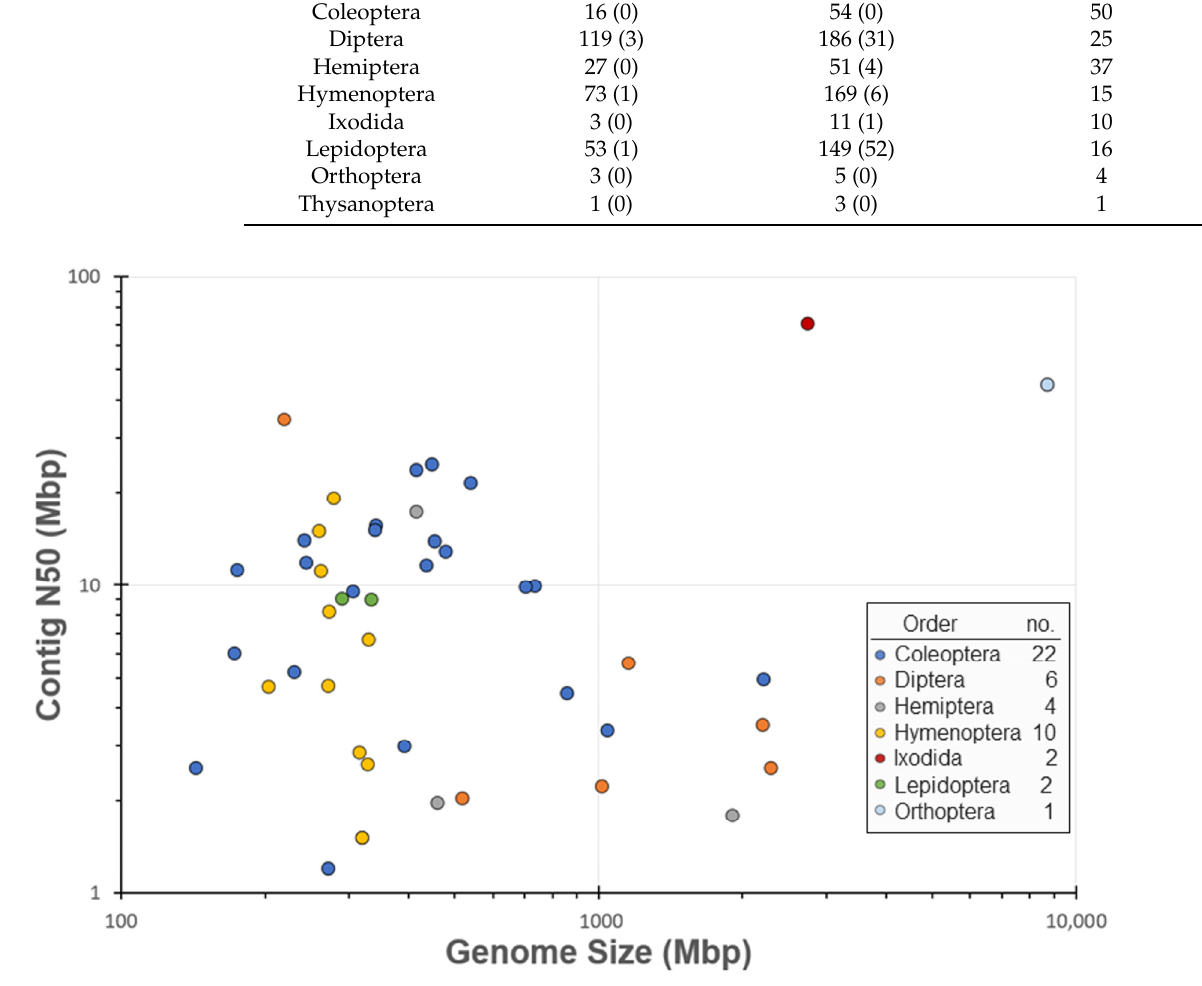
Figure 3. Plot of contig N50 (Mbp) versus genome size (Mbp) for Ag100Pest assemblies. This data was gathered from 47 insect genomes that have completed HiFi sequencing and were assembled by the Ag100Pest Initiative. Assemblies that require additional sequencing to achieve a high-quality assembly were excluded from the dataset. The data was plotted on a logarithmic axis to reduce skew from outliers, and data points were color-coded based on order.